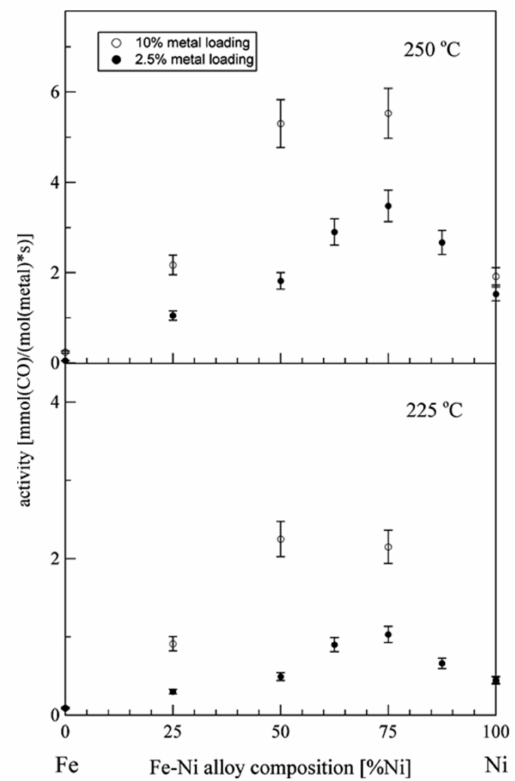
Figure 5. Measured rate of CO removal for a gas containing 2% CO in 1 bar of H 2 on FeNi catalyst loaded on spinel MgAl 2 O 4 support, as a function of the Fe content in FeNi alloy catalysts. Results are shown for two different temperatures and two metal concentrations of powder catalysts. Measure- ments were done using 150 mg of the FeNi/MgAl 2 O 4 catalyst confined by two layers of quartz wool at GHSV of 40,000 h − 1 (reprinted from Ref [92] © 2006, Elsevier